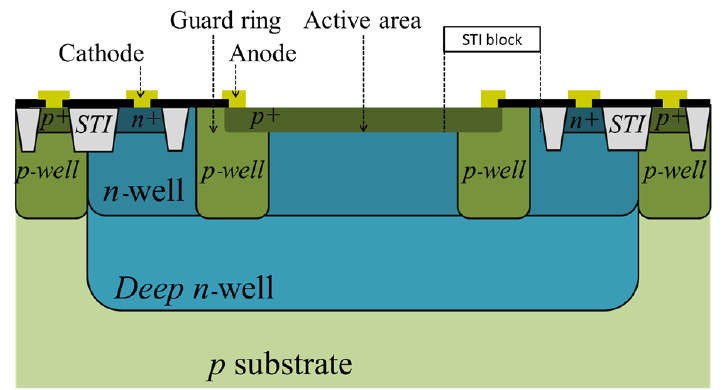
Figure 4. SPAD cross-section: p + anode within an n-well cathode with a p-well guard ring.